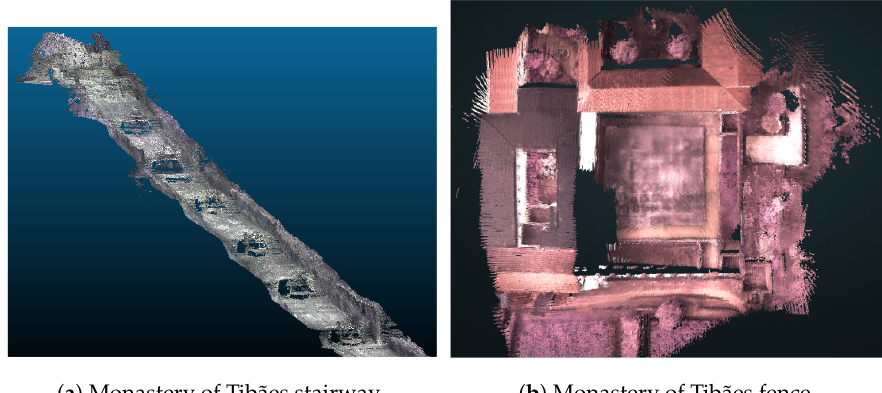
Figure 13. 3D reconstruction of the Monastery of